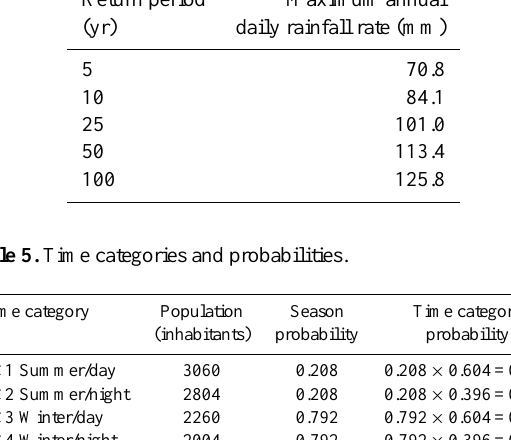
Table 4. Maximum annual daily rainfall rates at the case study.